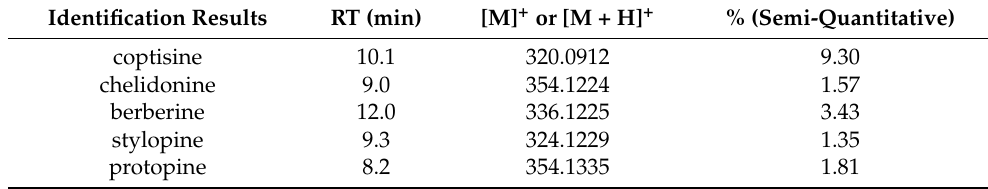
Table 1. Selected alkaloids identified by mass spectrometry in the C. majus latex alkaloid-rich fraction (S3). Identification Results